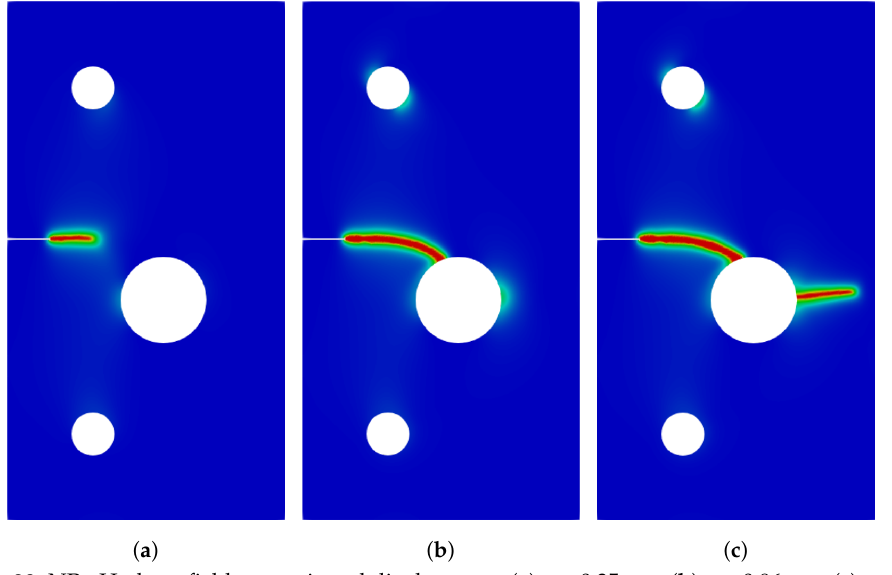
Figure 28. NPwH phase field at monitored displacement ( a ) u = 0.35 mm ( b ) u = 0.96 mm ( c ) u = 1.20 mm, with a displacement increment ∆ u = 1 e − 3 mm and a single stagger iteration.